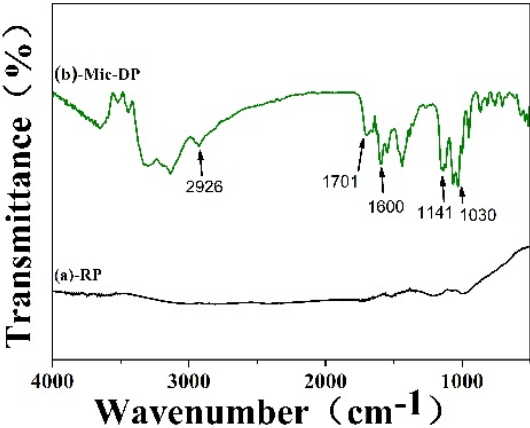
Figure 1. The FT − IR spectra of RP and Mic − DP.